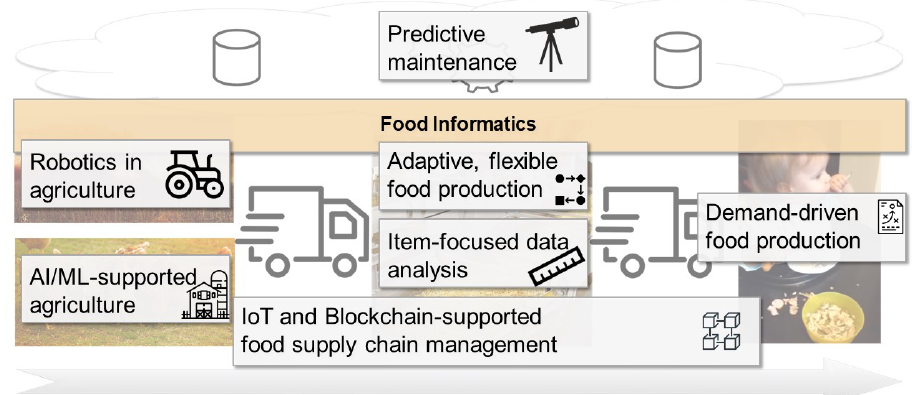
Figure 3. Landscape of use cases mapped to the food supply